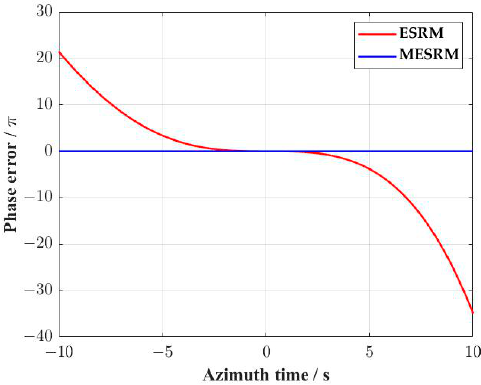
Figure 2. Phase error caused by range deviation as a function of the integration time in ESRM and MESRM.